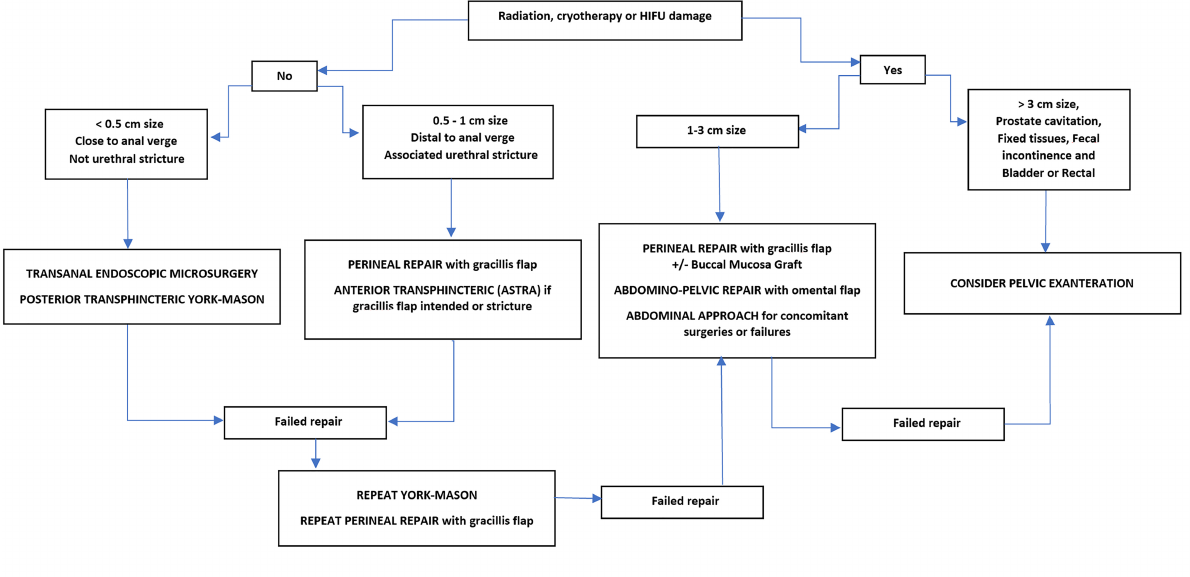
Figure 2 - Therapeutic algorithm followed for repair of urorectal